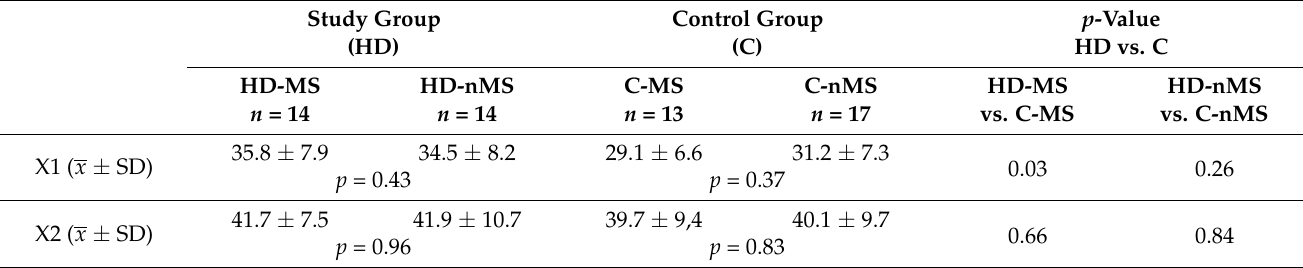
Table 2. Baseline comparison of the level of anxiety in the study (HD) and control group (C) with metabolic syndrome (MS) and without metabolic syndrome (nMS).